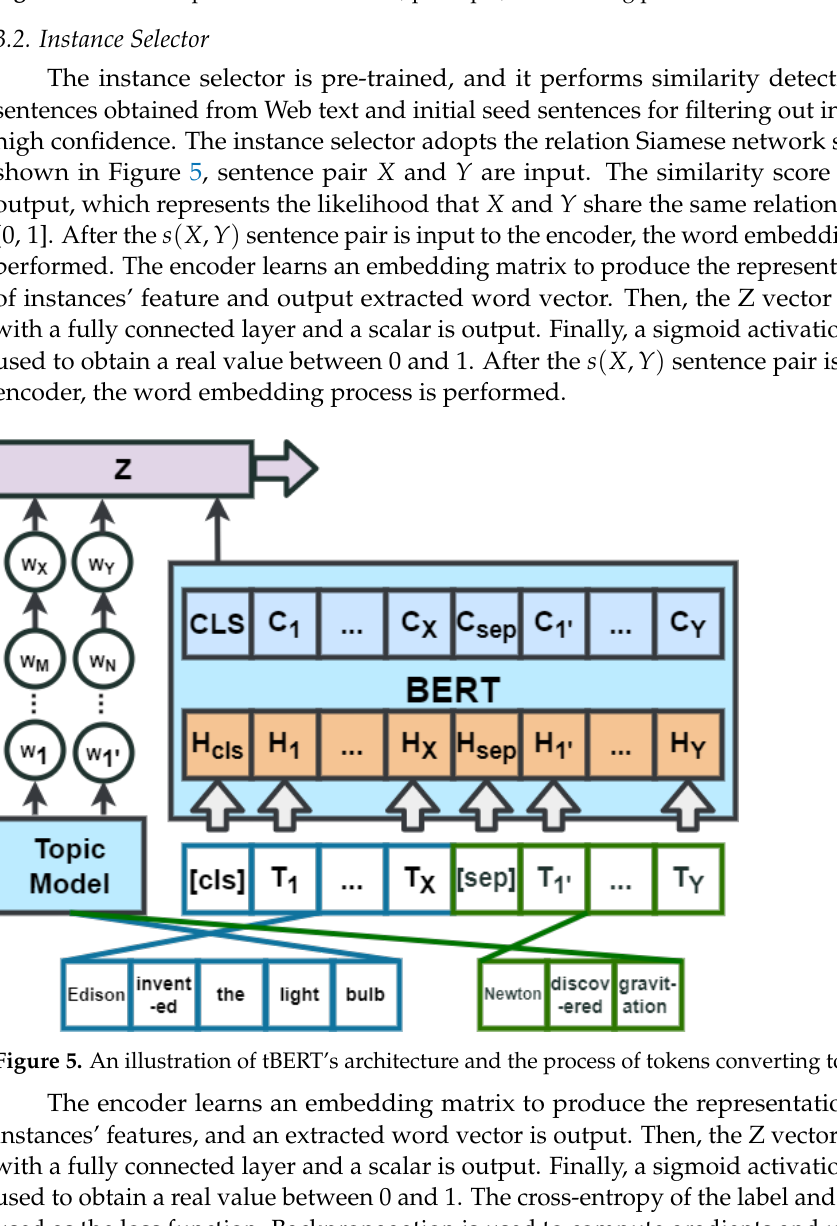
Figure 4. The description of the structure, principle, and training process of the instance selector.